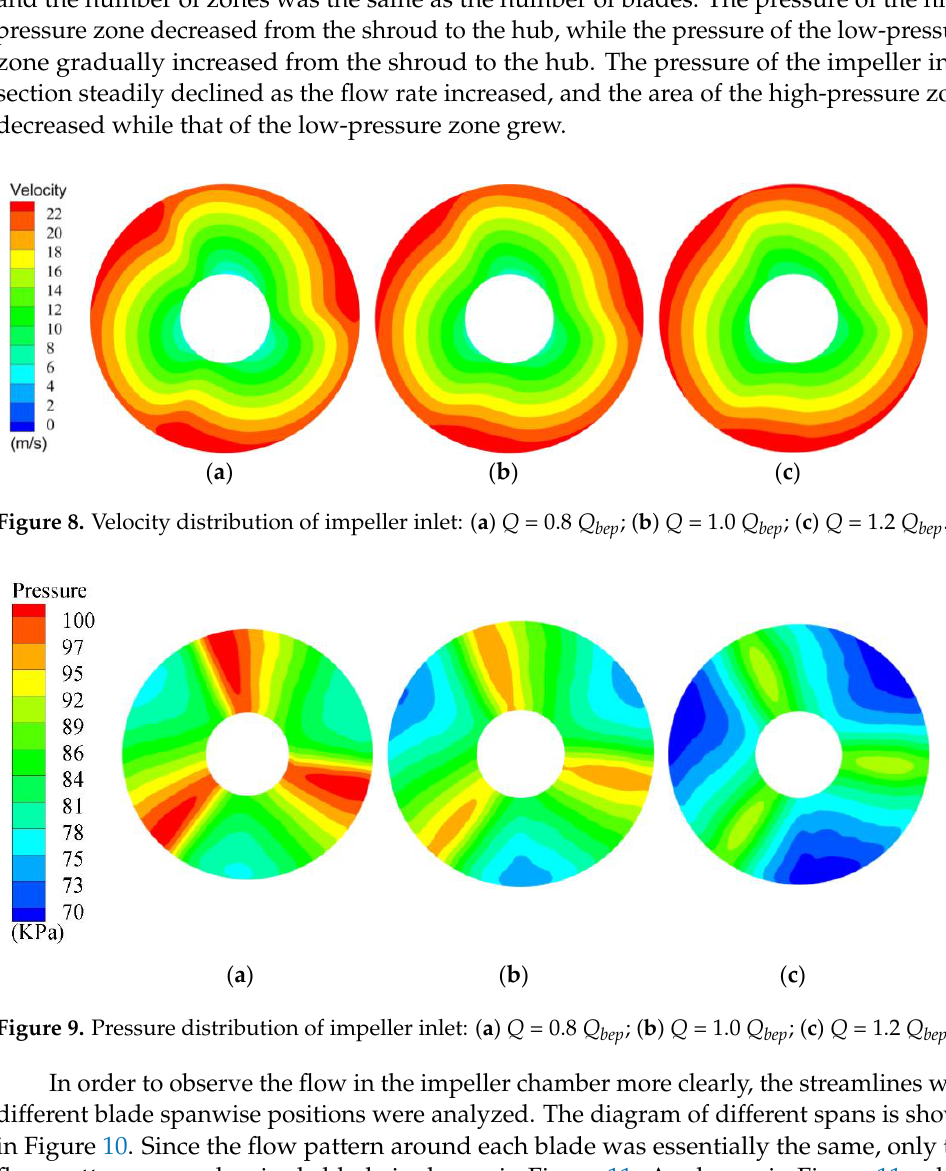
Figure 9. Pressure distribution of impeller inlet: ( a ) Q = 0.8 Q bep ; ( b ) Q = 1.0 Q bep ; ( c ) Q = 1.2 Q bep .